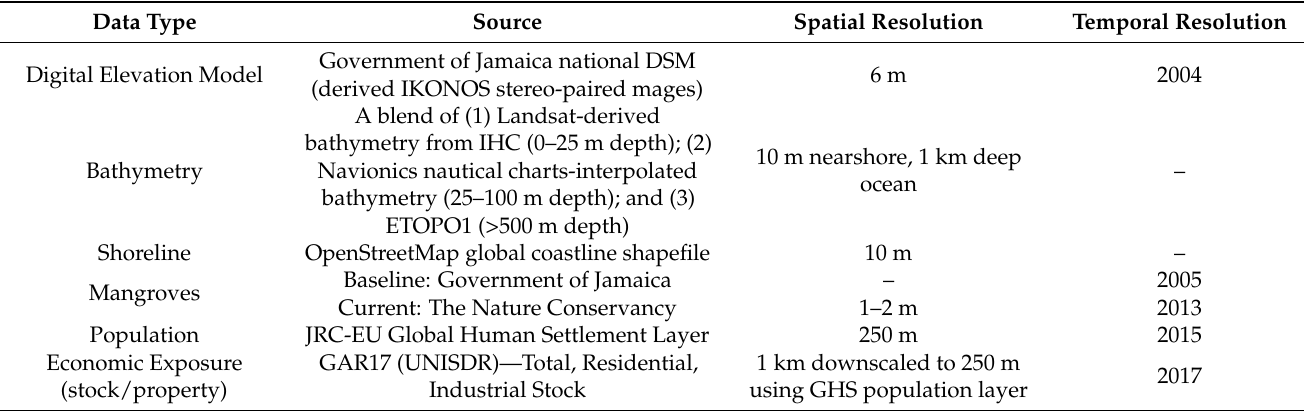
Table 4. Input datasets used for the Jamaica national-level storm surge analysis.